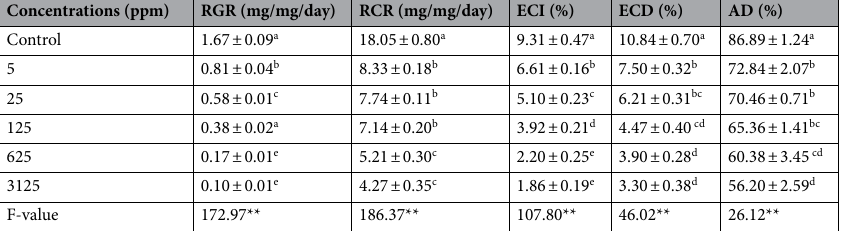
Table 4. Nutritional indices of S. litura when 6 days old instar larvae were fed on different concentrations of azadirachtin. **Significant at 1%. Values are Mean ± SE. Means followed by the same letter within the columns are not significantly different according to Tukey’s test at p ≤ 0.05.